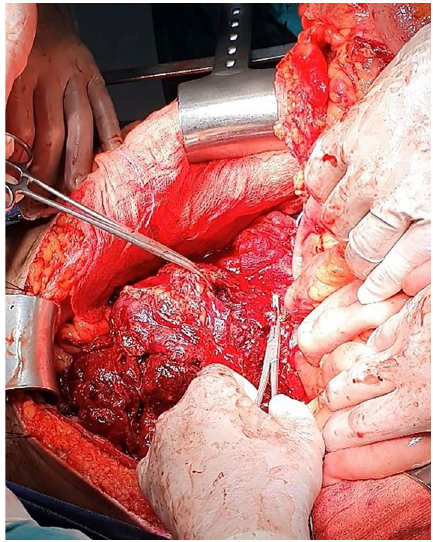
Fig. 2 Intraoperative photograph. Exposure of the bleeding mass following completion of the Cattell–Braasch maneuver. Α dhesions between the lymph node metastatic mass and right spermatic vessels necessitated their en bloc resection (right spermatic vessels clamped with Kelly